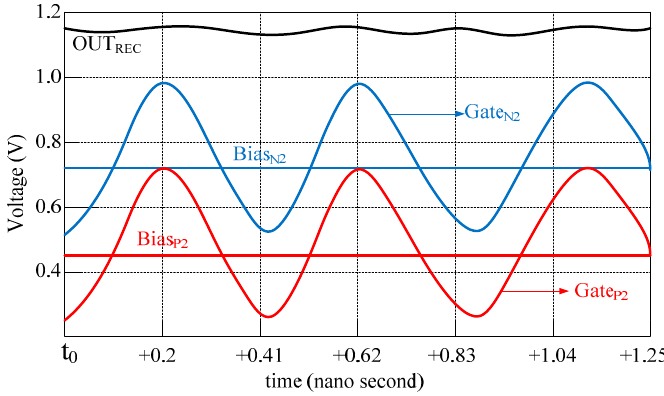
Figure 7. Second stage bias and gate voltages of the proposed gate boosting scheme.